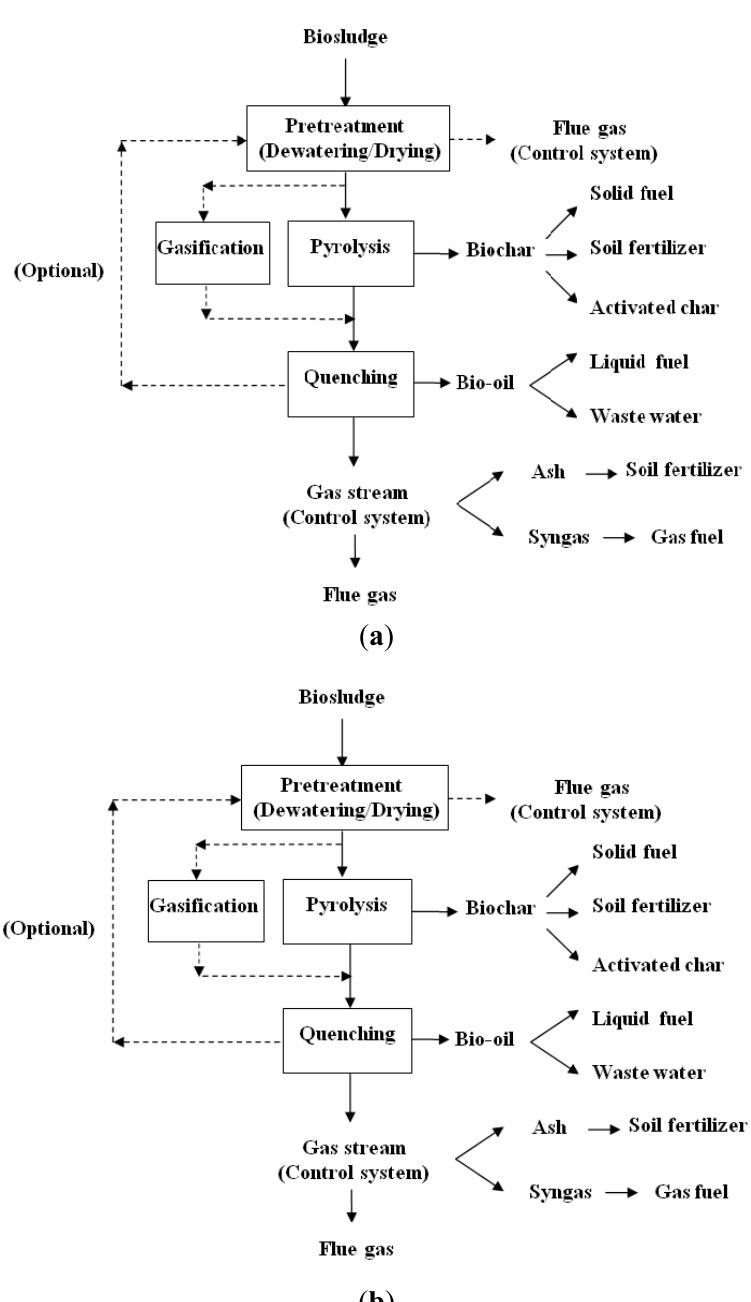
Figure 1. Conceptual flowchart of biosludge utilization using thermochemical